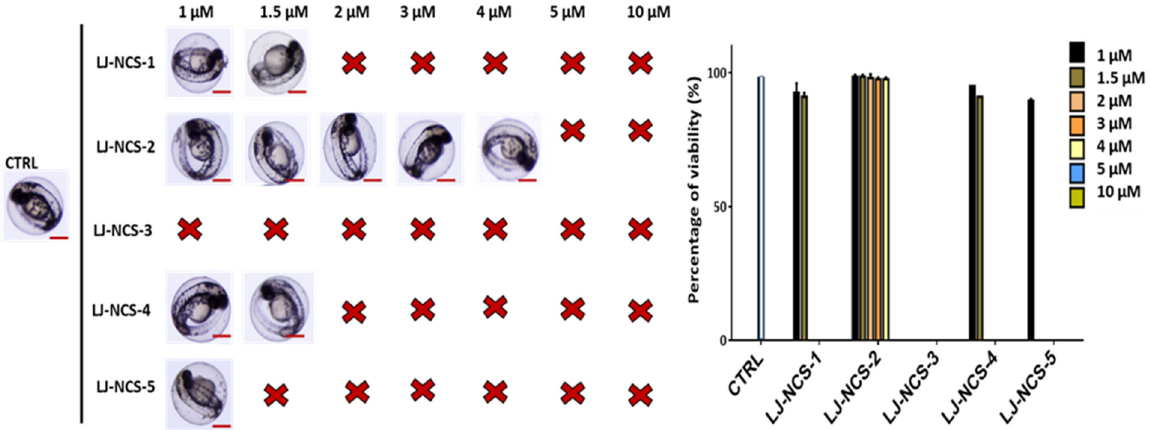
Figure 6. The effects of 48 h isothiocyanates treatment on morphology and mortality of 6 hpf zebrafish embryos at the experiment starting point. Representative images of embryos exposed to 1–10 µM of LJ-NCS-1–5 (n = 3 replicates, 50 embryos per replicate); bar scale = 450 µm Percentage of viability-data are represented as mean ± SD.